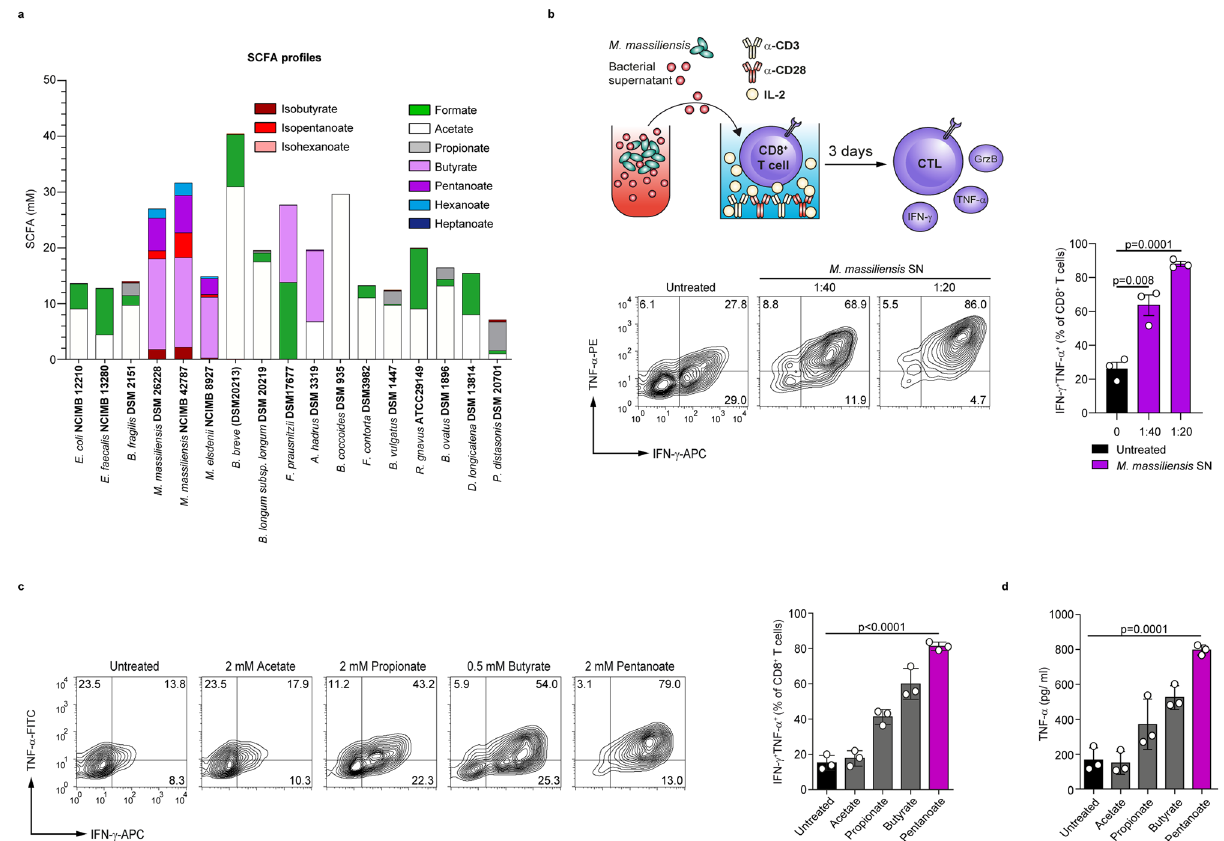
Fig. 1 Microbiota-derived SCFAs promote the production of effector cytokines in CTLs. a The production of SCFAs, branched-chain fatty acids (BCFAs) and medium-chain fatty acids (MCFAs) by 16 human commensals was measured by GC-MS. All bacteria were grown in vitro until the stationary growth phase before the measurement of fatty acids in supernatants ( n = 3 independent experiments). b The frequency of IFN- γ - and TNF- α -expressing CD8 + T cells cultured under suboptimal CTL conditions and stimulated with supernatant derived from M. massiliensis (1:40 or 1:20 supernatant-to-cell media ratios; n = 3 mice). c The percentage of IFN- γ + TNF- α + CTLs, derived from SPF mice and treated with the indicated SCFAs for three days ( n = 3 mice). d The secretion of TNF- α from CTLs treated with SCFAs was determined by ELISA ( n = 3 mice). Statistical analysis was performed by two-tailed unpaired Student ’ s t -test; mean ± s.e.m. values are presented. Source data are provided as a Source data fi